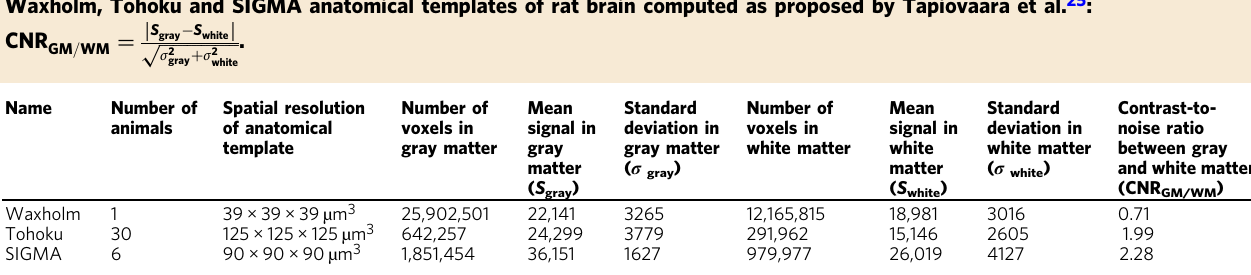
Forthe TohokuandSIGMAtemplates,the GMand WMarede fi nedfrom thecorrespondingtissueprobabilitymaps.For theWaxholmtemplate,theGMandWMarede fi ned fromthelabeledregionsin the corresponding atlas. Source data are provided as a Source Data fi